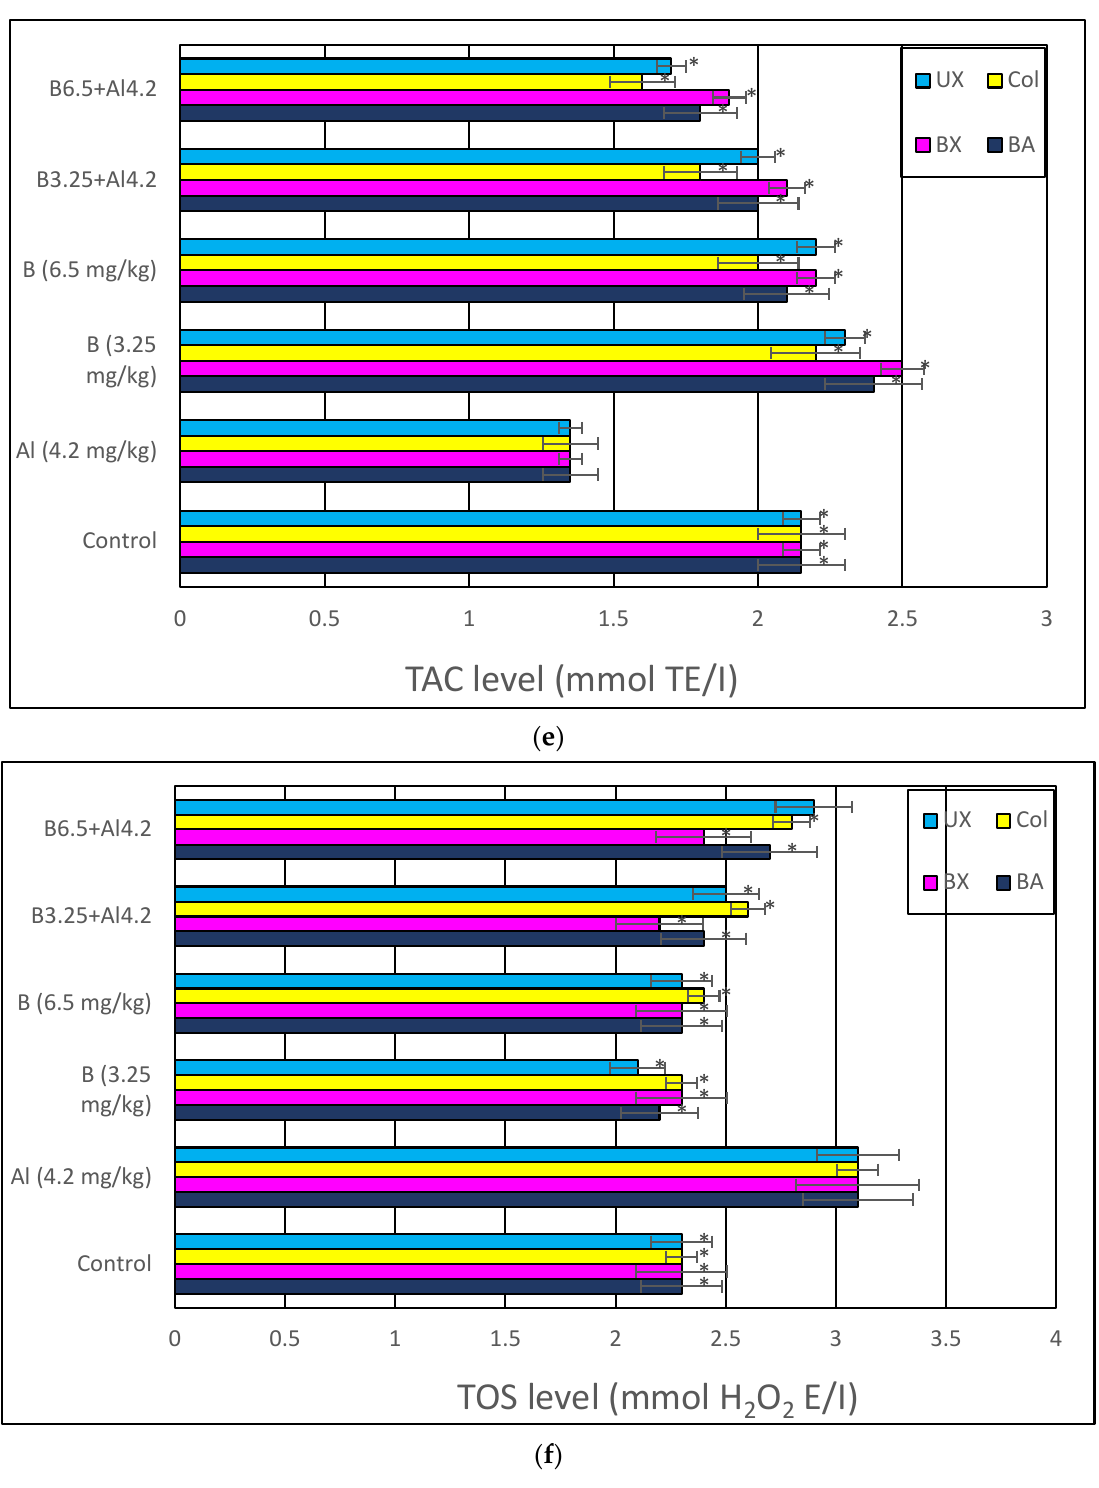
Figure 8. In vivo effects of treatments with boron compounds and Al on ( a ) SOD, ( b ) CAT and ( c ) GSH-Px enzyme activities, and ( d ) MDA, ( e ) TAC and ( f ) TOS levels in brain tissue. Symbol (*) represents a statically significant difference compared to the Al-treated group. Table 4 reflects the rates of MNPKEs in rat bone marrow cells in different experi- mental groups. A significantly greater frequency of MNPKEs was observed in Al-treated rats compared to controls. Treatment with 4.2 mg/kg of Al resulted in an MNPKE fre- quency of 27.78‰, which was significantly ( p < 0.05) higher than the 13.40‰ scored in the control animals. Conversely, the number of MNPKEs was not significantly different be- tween the all-boron compound-treated rats at doses of 3.25 and 6.5 mg/kg to the control rats ( p > 0.05).